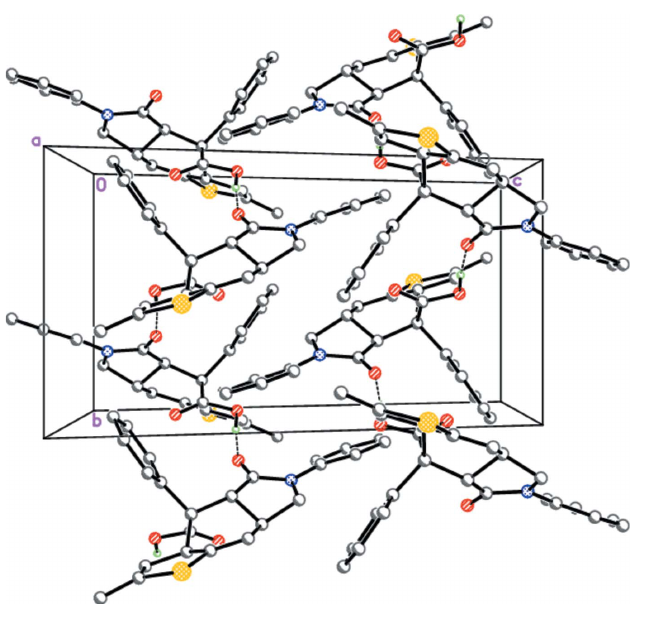
Figure 6 The hydrogen-bonded centrosymmetric dimers of II . Dashed lines indicate the intermolecular O—H (cid:3)(cid:3)(cid:3) O hydrogen bonds. The minor occupancy –COOH groups are omitted for